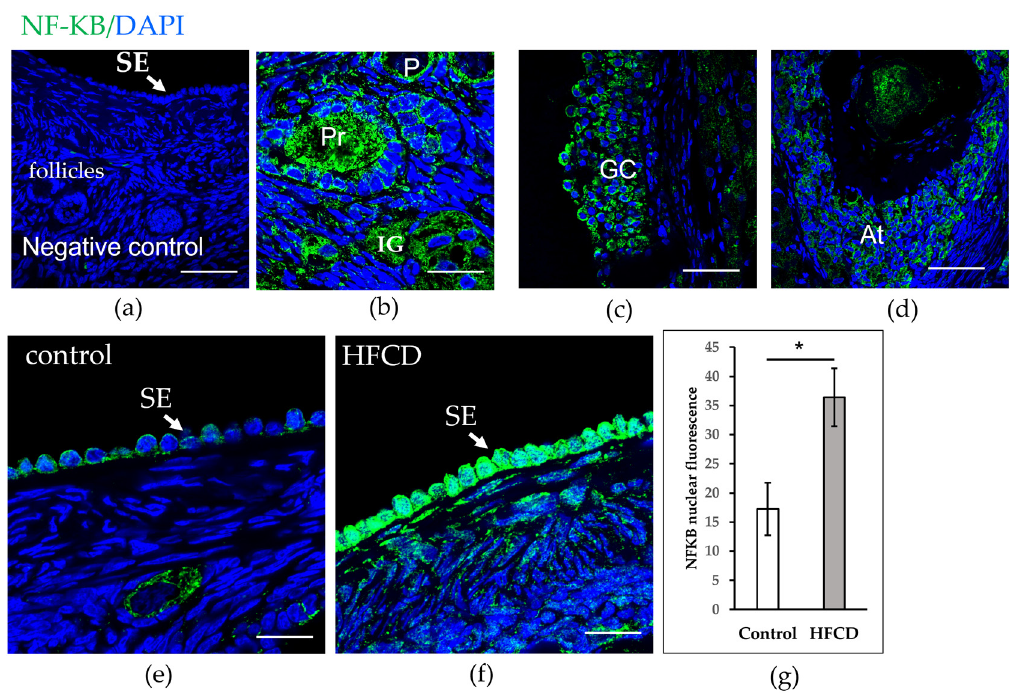
Figure 4. NF- ΚΒ protein localization and levels in ovaries of chinchilla rabbit . ( a ) Negative control without primary antibody, no signal detected. ( b – d ) Cytoplasmic localization of NF- ΚΒ (green) in interstitial gland (IG), Primordial follicles (P), Primary (Pr), mural granulosa cells (GC), and Atretic follicle (At). The nuclei are stained with DAPI (blue). ( e ) Cytoplasmic localization of NF- ΚΒ in surface epithelium (SE) and oocyte of the primordial follicle of chinchilla rabbit, fed with a control diet, and ( f ) cytoplasmic and nuclear localization of NF- ΚΒ (green) in the ovarian surface epithelium of chinchilla rabbit fed with HFCD. Scale bars: ( a – d ) 50 µm; ( e , f ) 100 µm. ( g ) Densitometric quantification was performed on nuclear NF- ΚΒ expression of the surface epithelium of chinchilla rabbit fed with either a control diet or HFCD. Data are expressed as mean ± ESM * p < 0.05.